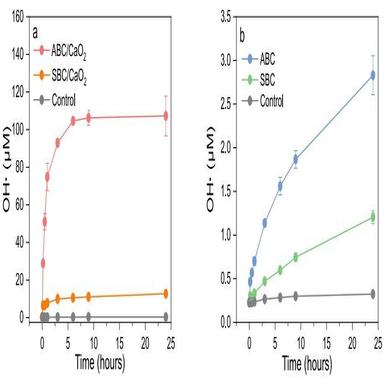
Detected OH⋅ radicals in the batch experiments with a) ABC/CaO2 and SBC/CaO2; b) ABC and SBC.